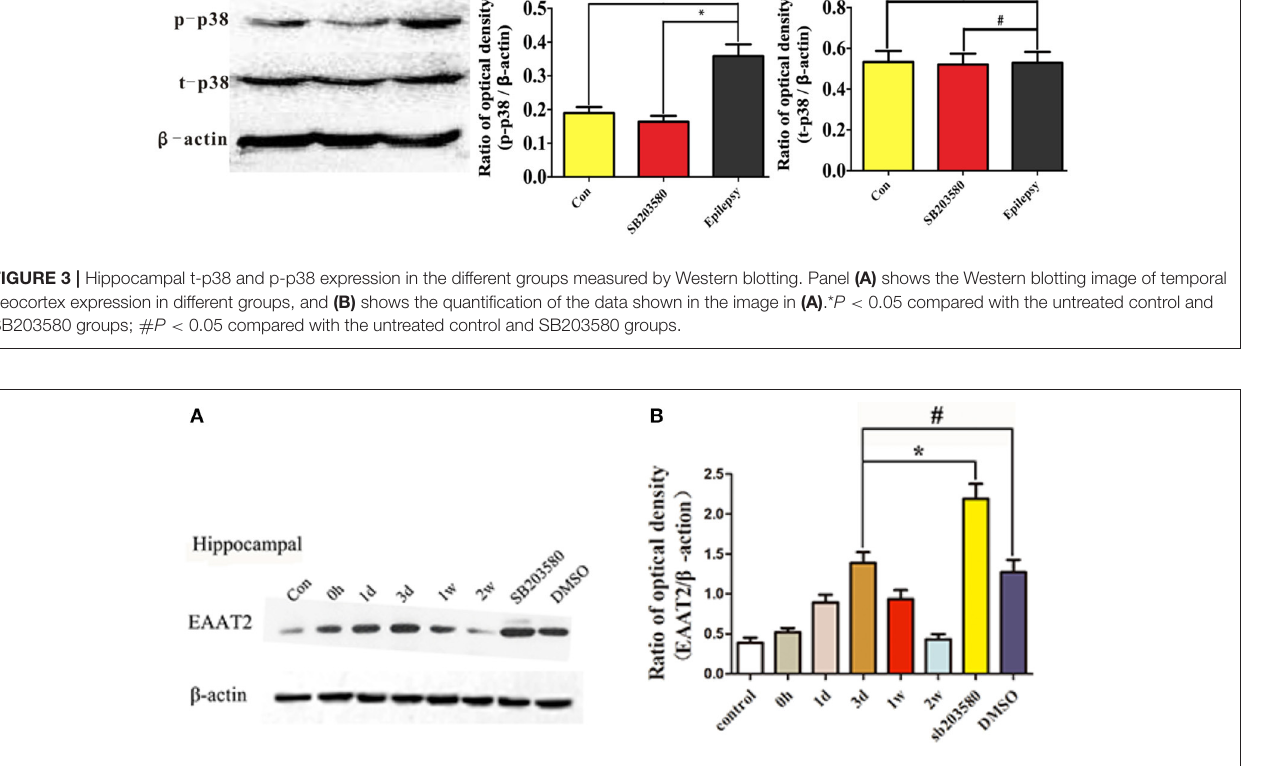
increase in the number of EAAT2-positive cells was significantly greater in the SB203580 group than in the seizure group at 3 d ( P <